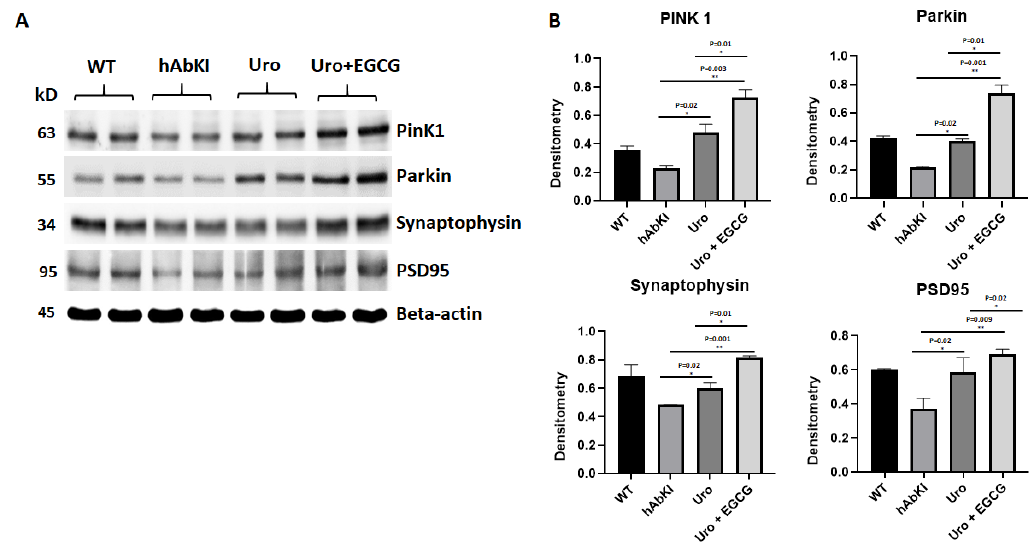
Figure 5. Immunoblotting analysis of mitochondrial mitophagy and synaptic proteins . ( A ) Rep- resentative immunoblots for untreated and hAbKI mice and treated hAbKI Urolithin A and EGCG. ( B ) Quantitative-densitometry analysis of PINK1, Parkin, synaptophysin and PSD95, which shows significant reduction in the hAbKI mice compared to the treated hAbKI mice Urolithin A and EGCG. Autophagy Proteins: Significantly increased levels of autophagy proteins (Beclin p = 0.05, ATG5 p = 0.004, LC3B1 p = 0.003, LC3B2 p = 0.0001 and BCL2 p = 0.04) were found in urolithin A-treated 7-month-old hAbKI mice relative to untreated hAbKI mice (Figure 6), and increased levels are even higher for autophagy proteins (Beclin p = 0.04, ATG5 p = 0.002, LC3B1 p = 0.003, LC3B2 p = 0.0001 and BCL2 p = 0.04) in combined treatment of urolithin A+EGCG in hAbKI mice. In hAbKI mice treated with urolithin A compared to combination treatment of urolithin A+EGCG, autophagy proteins Beclin ( p = 0.05), ATG5 ( p = 0.01) and BCL2 ( p = 0.006) significantly increased, indicating that combination treatment is better than urolithin A alone for autophagy.